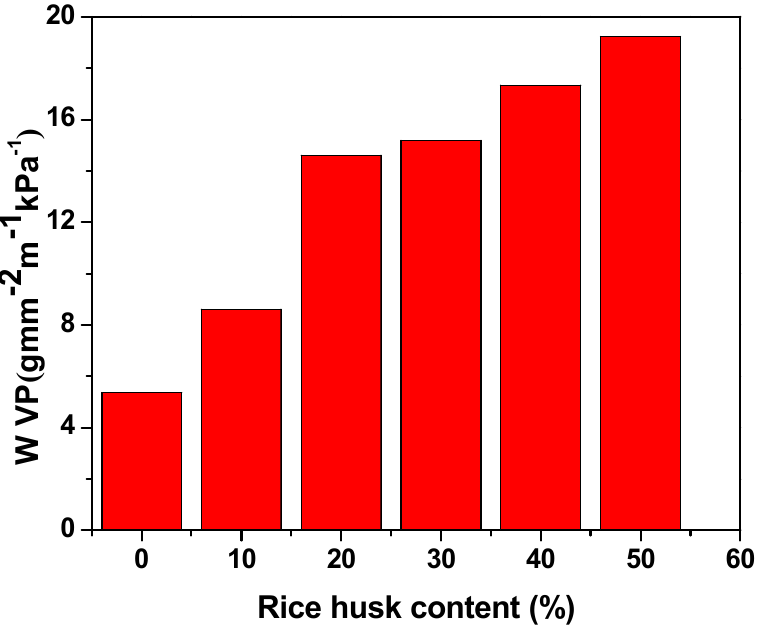
Figure 5. Water vapour permeability of the LDPE/RH biocomposite films with respect to RH content.